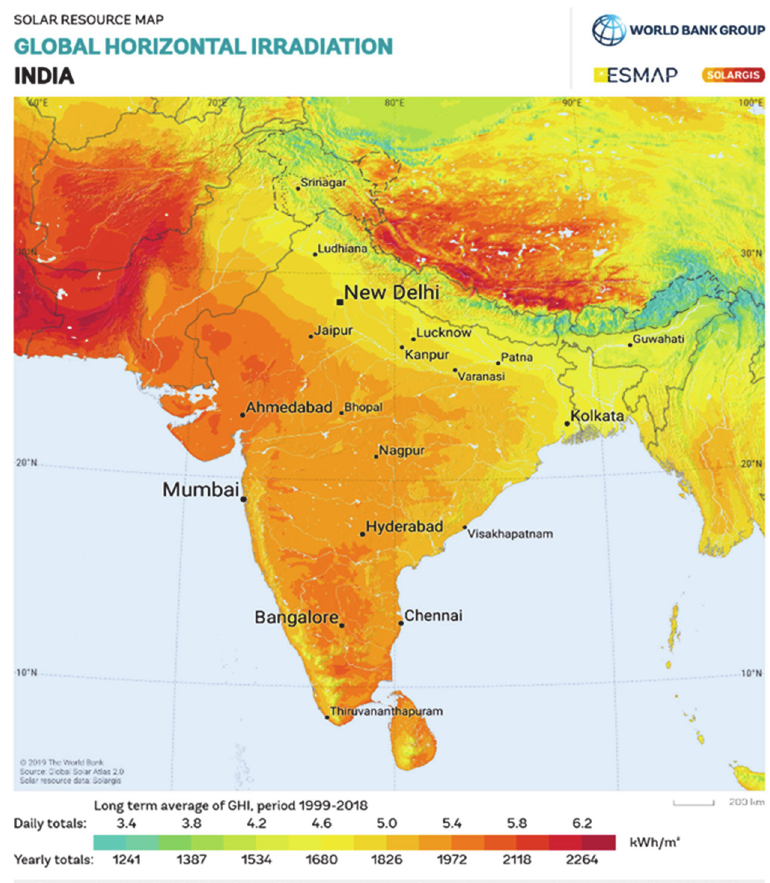
Figure 3. Solar global horizontal irradiation graph of India © 2023 The World Bank, Source: “Global Solar Atlas 2.0, Solar resource data: Solargis”.